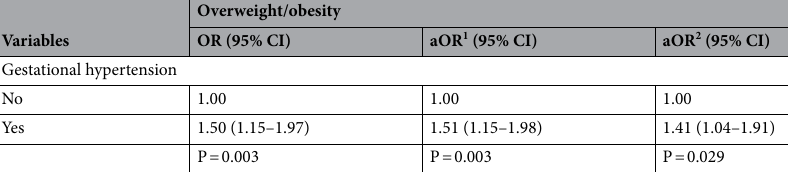
Table 3. Associations of maternal gestational hypertension with overweight/obesity in adolescent offspring (univariate and multivariate analyses). OR crude odds ratio, aOR 1 adjusted odds ratios for age and sex, aOR 2 adjusted odds ratios for age, sex, birth weight, and maternal pre/early pregnancy BMI, CI confidence